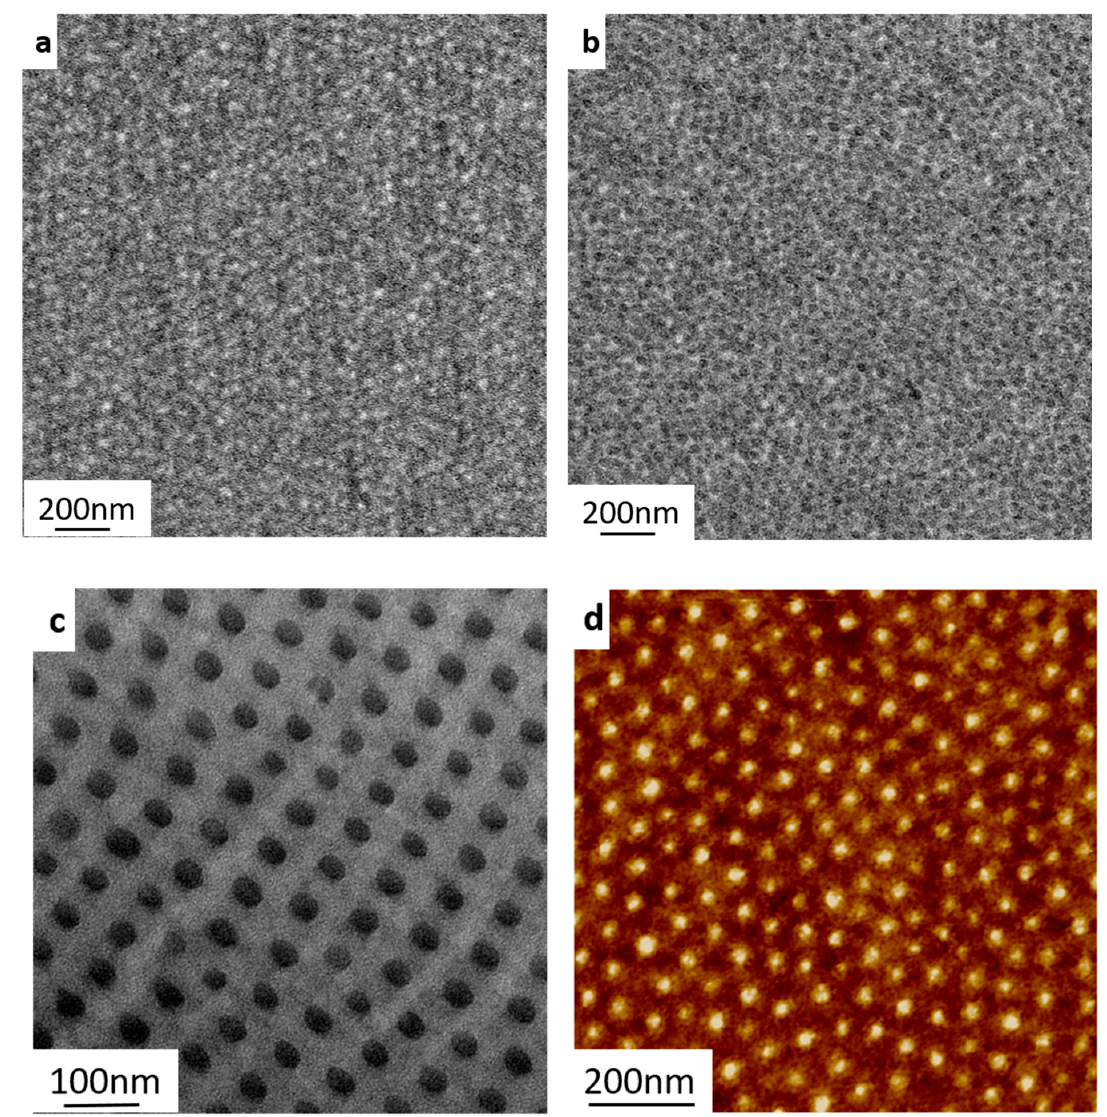
ff erent molecular weights cast from chloroform. Figure 2. TEM micrographs of PS- b -P4VP- b -PSMA of different molecular weights cast from Figure 2. TEM micrographs of PS- b -P4VP- b -PSMA of di ( a ) PS 71 - b -P4VP 17 - b -PSMA 1291 stained with RuO 4 . ( b ) PS 71 - b -P4VP 17 - b -PSMA 1291 stained with RuO